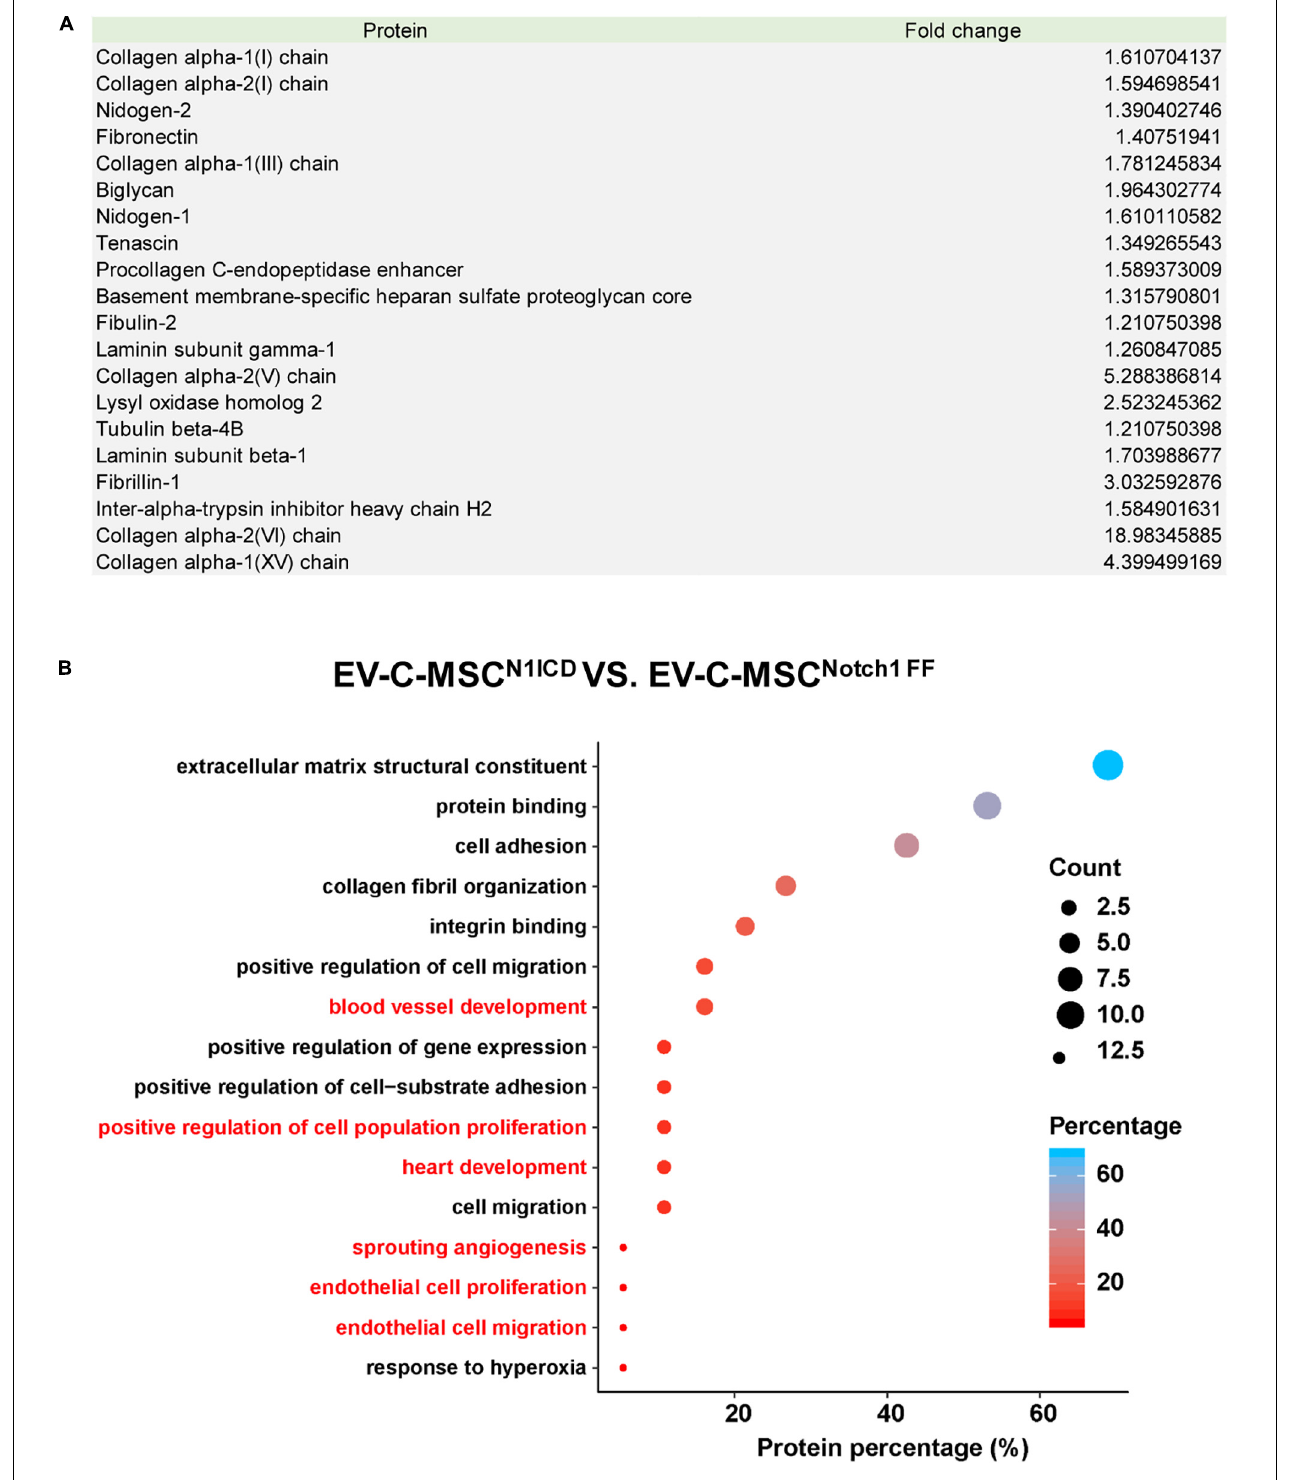
FIGURE 3 | Proteomic profile in EVs derived from N1ICD-overexpressing C-MSCs. (A) List of enriched proteins in EV-C-MSCs N1ICD relative to EV-C-MSCs Notch1FF . (B) GO protein annotation and pathway enrichment analysis. A , Pathway enrichment analysis on differentially expressed proteins in EVs. As expected, many terms referring to biological processes related to various functions of C-MSCs, including extracellular matrix, collagen, proliferation, apoptosis, cell cycle, differentiation, migration, heart development, and angiogenesis were pointed out.